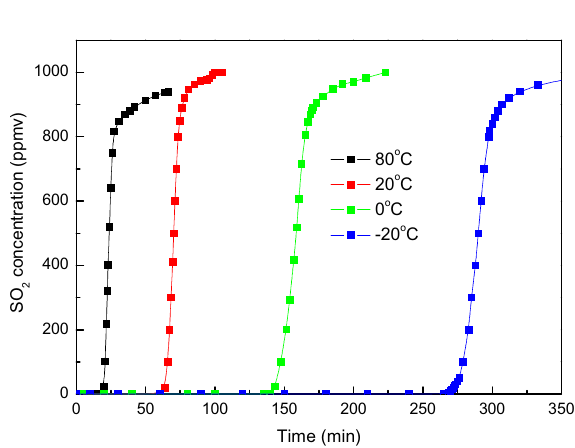
Figure 10. Breakthrough curve of SO 2 adsorption over CAC at various temperatures (SO 2 = 1000 ppmv, O 2 = 6 vol.%, flow rate = 1 L/min, space velocity = 5000 h −1